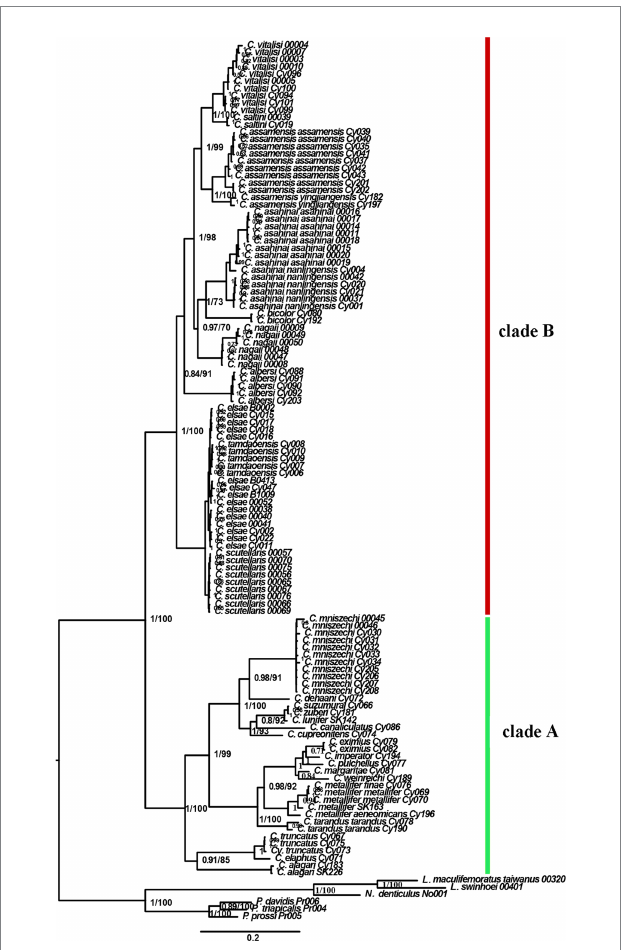
FIGURE 2 Bayesian topology showing the relationships within Cyclommatus stag beetles and outgroups. Numbers next to each node represent Bayesian posterior probabilities (first number) and partitioned maximum likelihood bootstrap support (second number). The phylogenetic tree is based on Bayesian inference analysis of concatenated DNA sequence data from 16S rDNA, COI, 28S rDNA, ITS, Cytb, and Wingless.